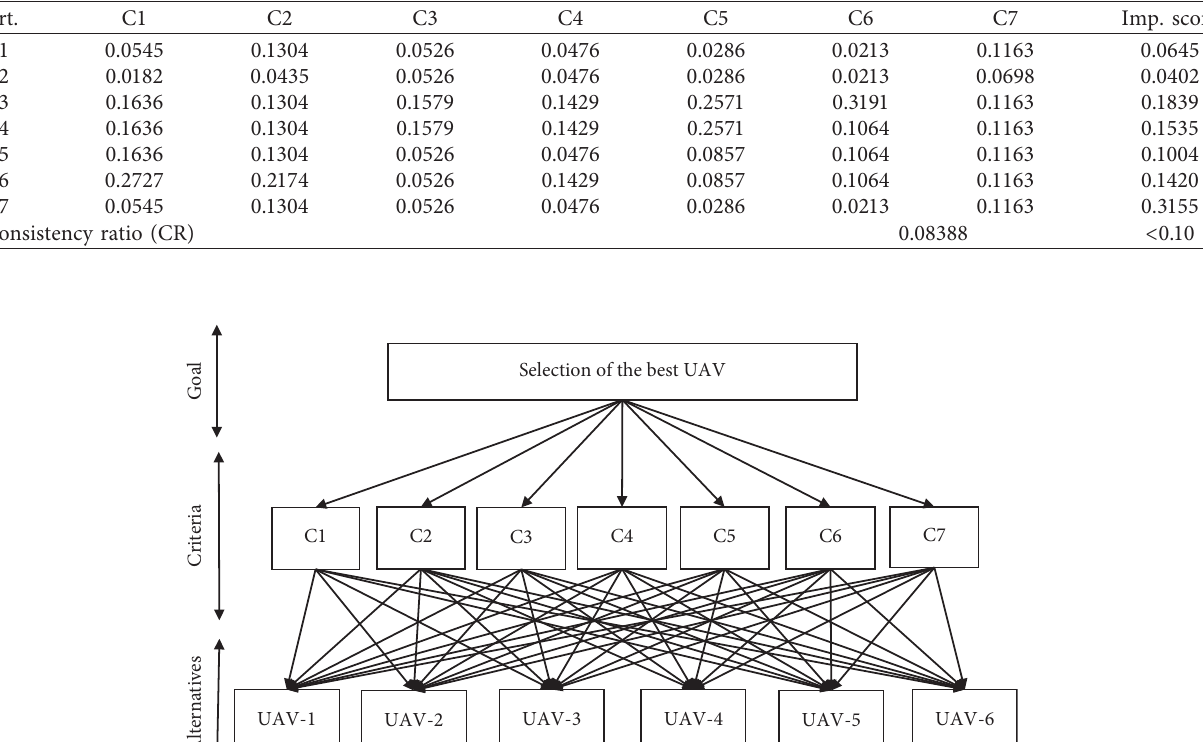
Table 4: Criteria and their important score.